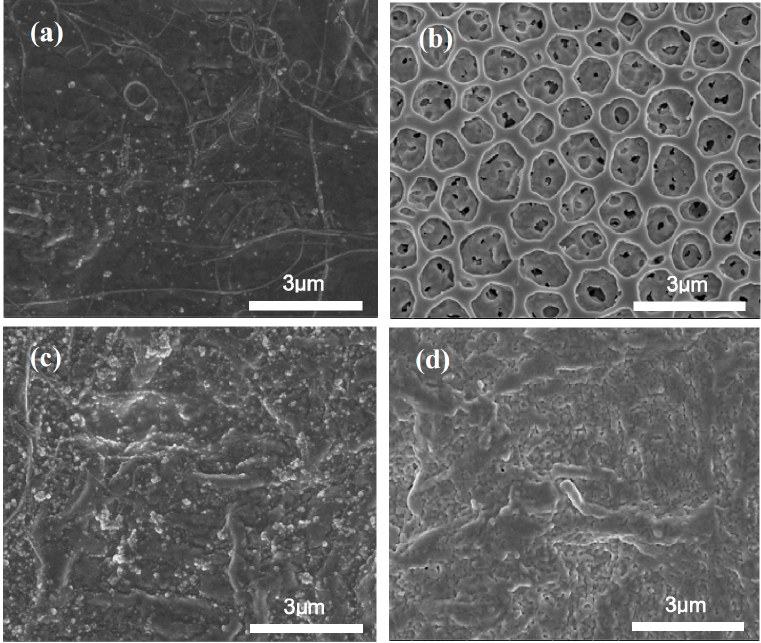
Figure 1. SEM morphology of polymer/MWCNT composite films before the test ( a ) MWCNT film; ( b ) EC/MWCNT film; ( c ) PEO/MWCNT film; and ( d ) PVP/MWCNT film.